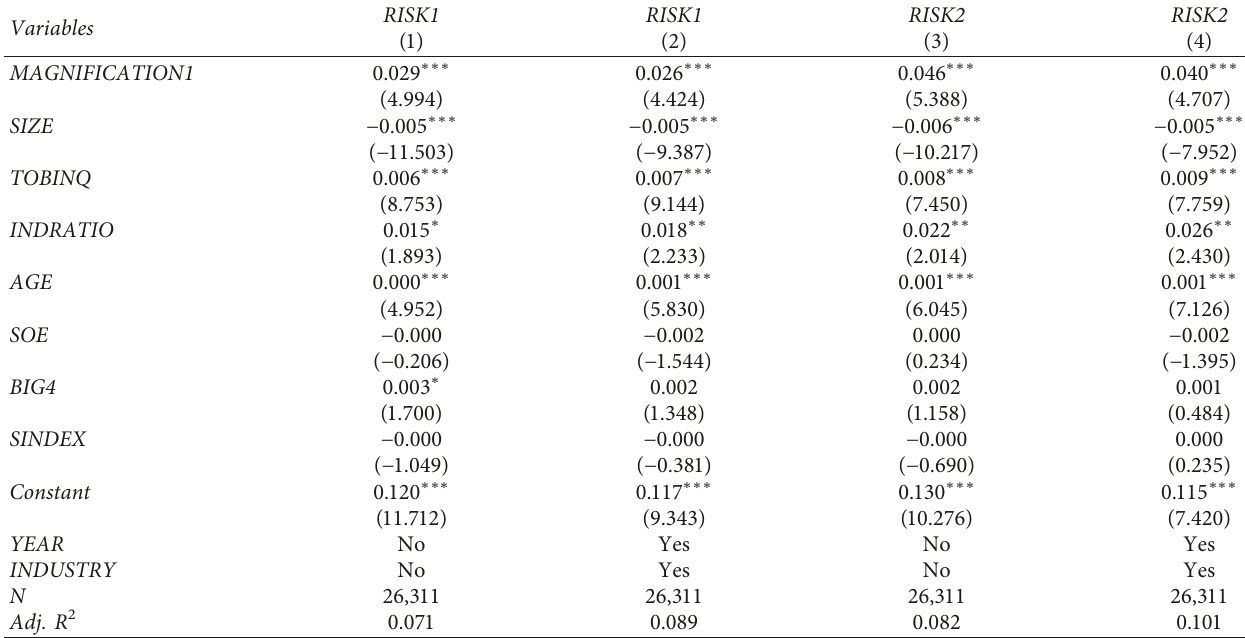
Table 6: The impact of amplification effect on audit